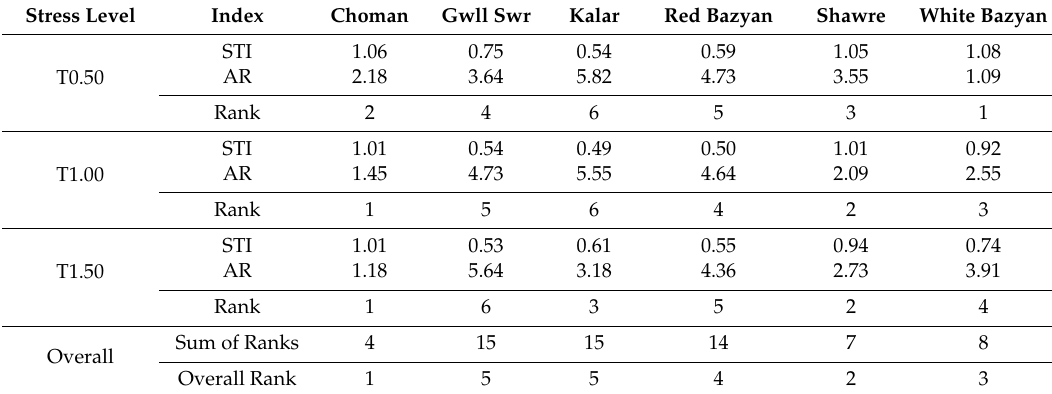
Table 6. Rank of rice genotypes by the stress tolerance index (STI) and the average sum of ranks (ASRs) based on callus growth characters under stress conditions. Genotypes with the highest STI and lowest ASR values were considered to be the best genotypes and the best performance of each phenotype was assigned the lowest